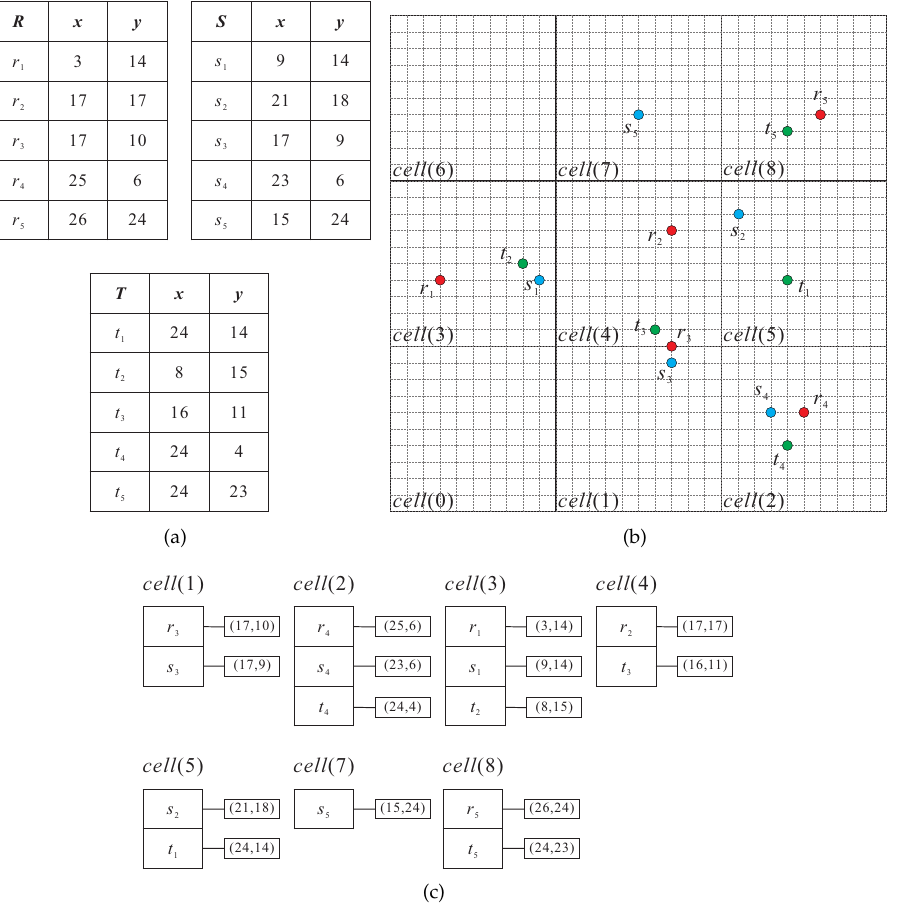
Figure 2. Illustration of grid structure and HDFS. ( a ) Heterogeneous objects; ( b ) Grid structure; ( c ) Data on